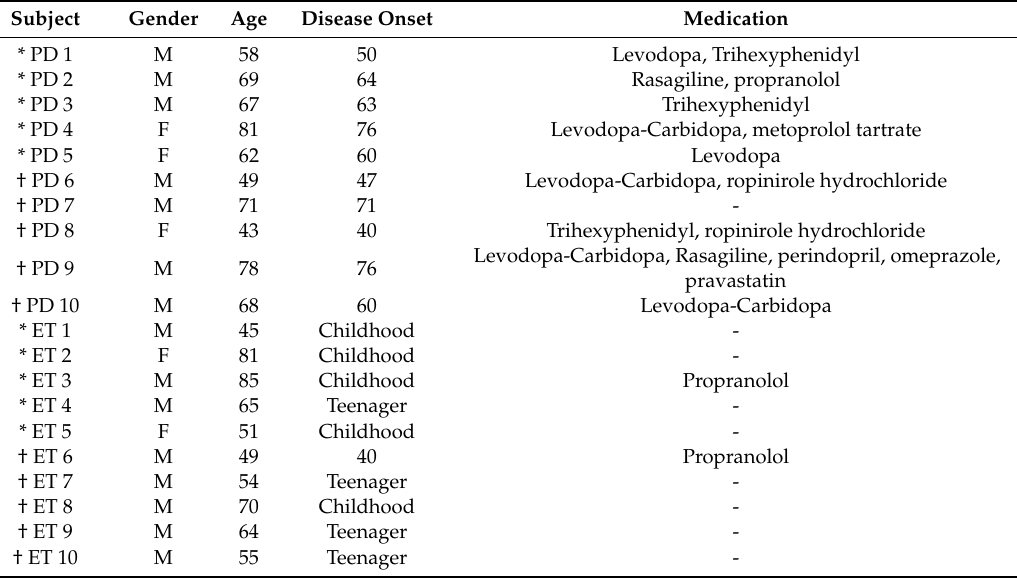
Table 1. Overview of patients’